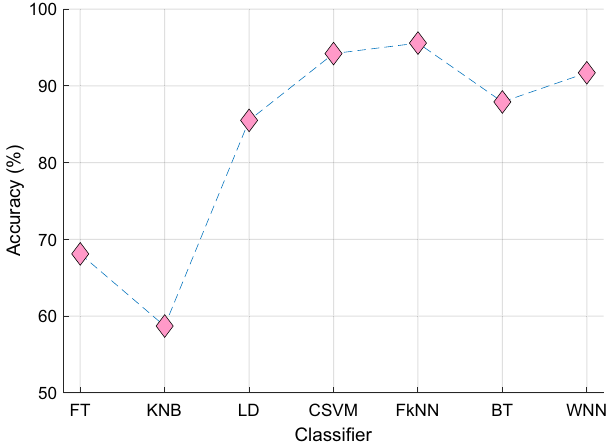
Figure 3. The classification accuracy of seven standard shallow classifiers was attained using tenfold cross- validation on the UNBC-McMaster dataset. The FT, fine tree; KNB, kernel naïve Bayes; LD, linear discriminant; CSVM, cubic support vector machine; FkNN, fine k-nearest neighbor; BT, bagged tree; WNN, wide neural